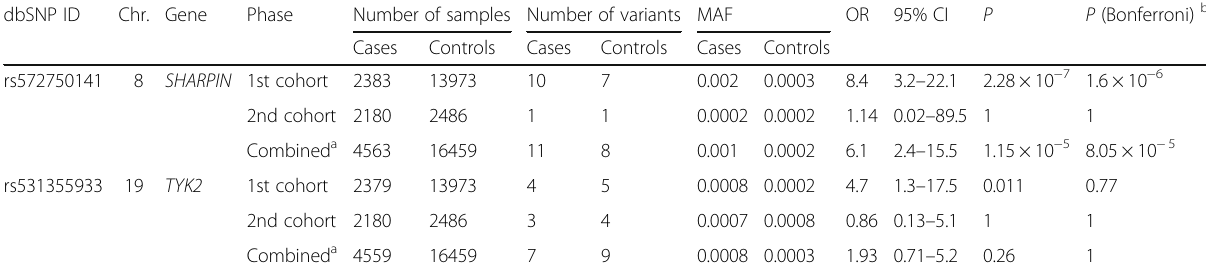
Table 2 Associations of the two variants in SHARPIN and TYK2 with the risk of LOAD dbSNP ID Chr. Gene